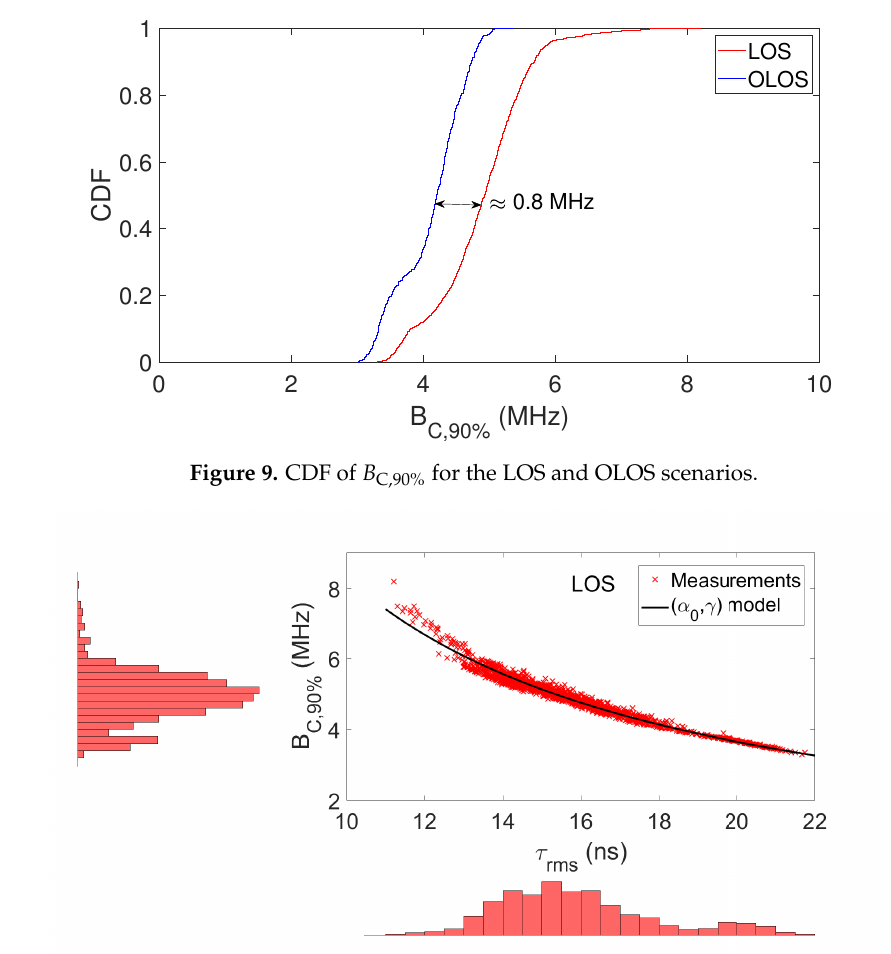
Figure 10. Scatter plot of the 90% coherence bandwidth versus τ rms in LOS conditions.